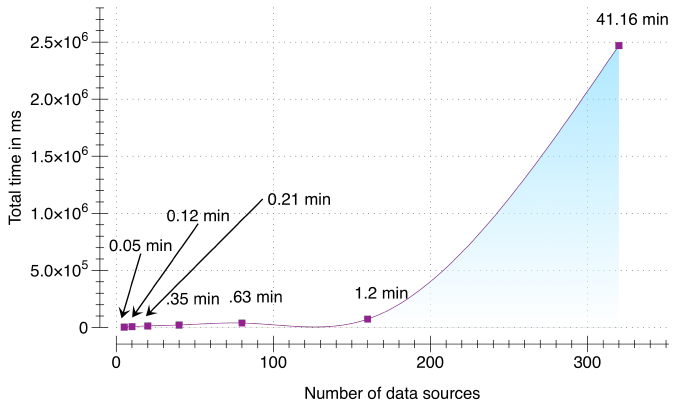
Figure 10. Stress testing of scalability.